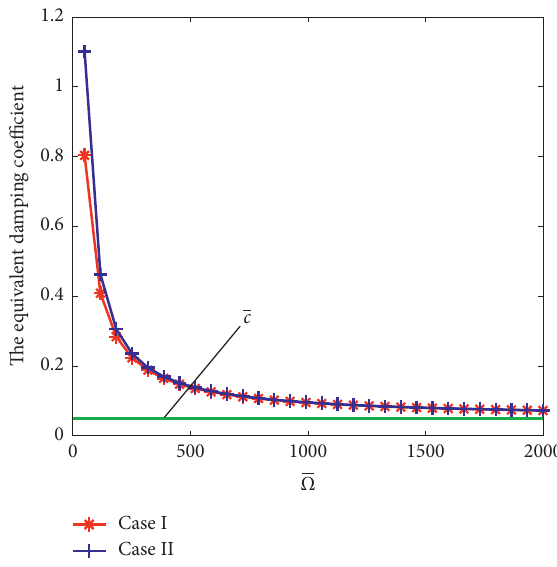
Figure 36: The equivalent damping coefficients versus cutting force for cases I and II.